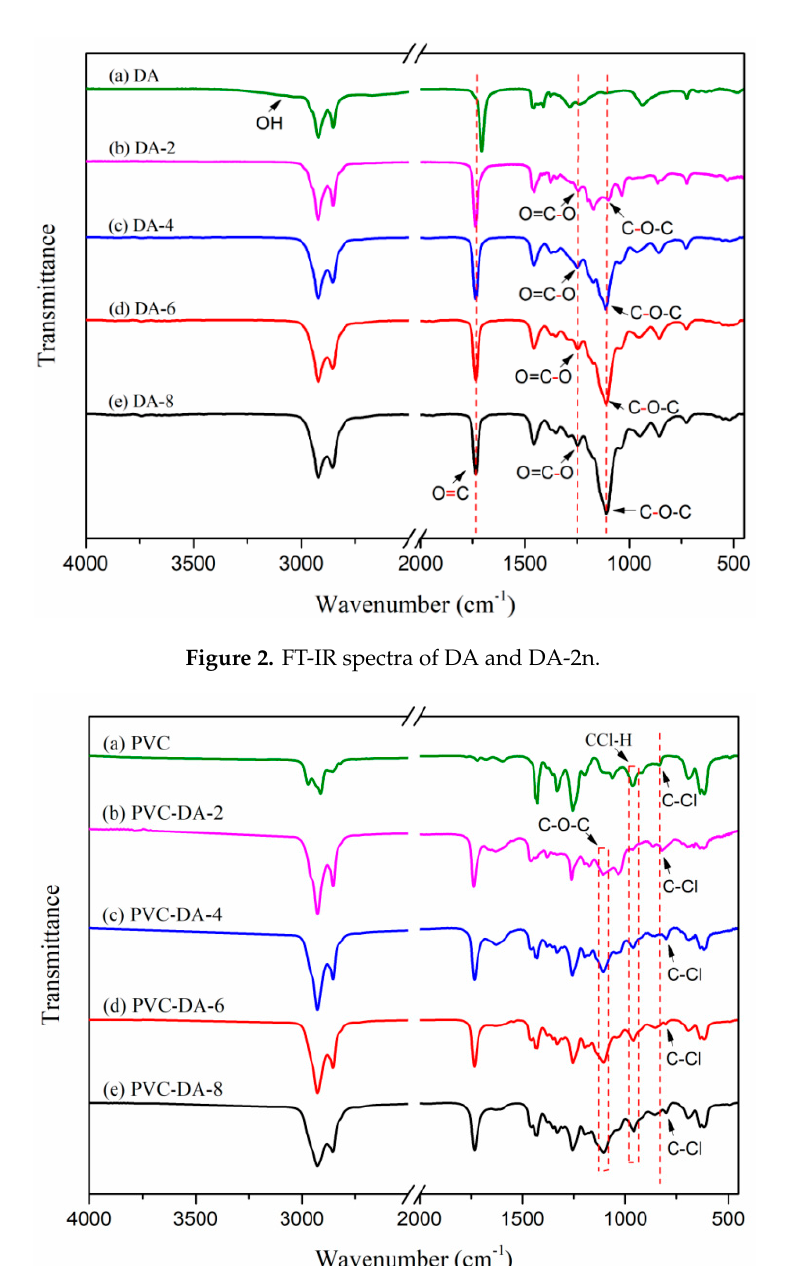
Figure 2. FT ‐ IR spectra of DA and DA ‐ 2n.